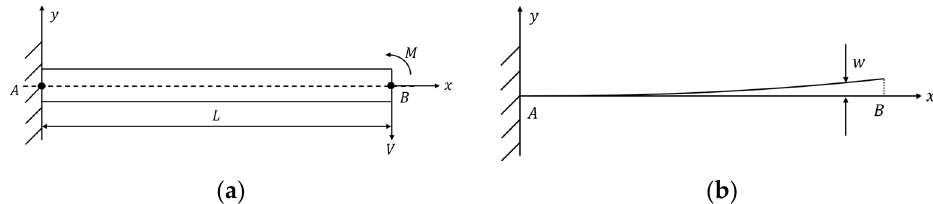
Figure A2. Deflection of a cantilever beam: ( a ) the cantilever beam subjected to bending moment and shear force; ( b ) deflection curve of the cantilever beam.